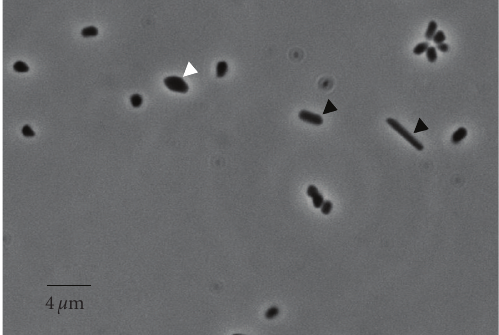
Figure 2: Phase contrast photomicrograph of strain ETD6. Strain grown in the liquid medium DSC-97 under optimal conditions until OD6 00nm = 1 . 0. Black arrows show rod-shaped cells, white arrows show cocci shaped-cell (30 hours of growth).